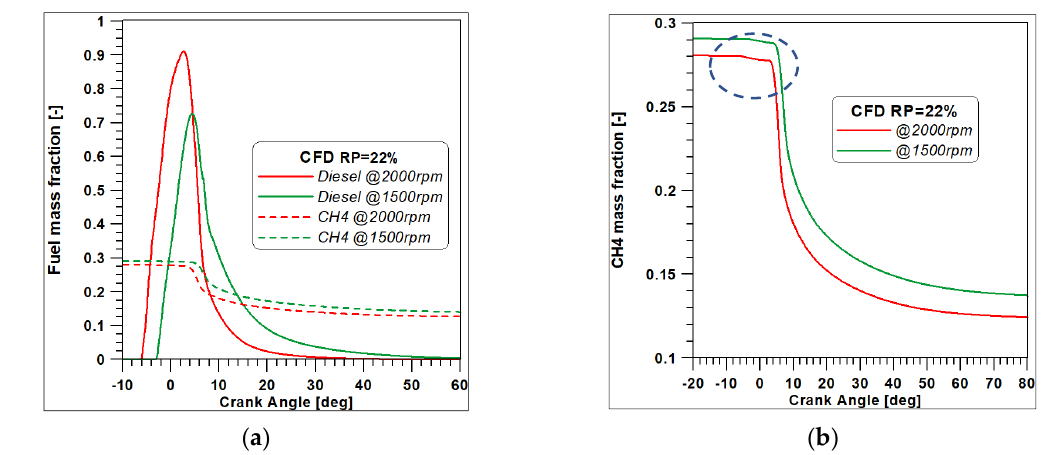
Figure 7. ( a ) Mass fractions of n-dodecane and methane comparison for RP = 22% at different engine speeds; ( b ) methane mass fraction comparison for RP = 22% at different engine speeds.